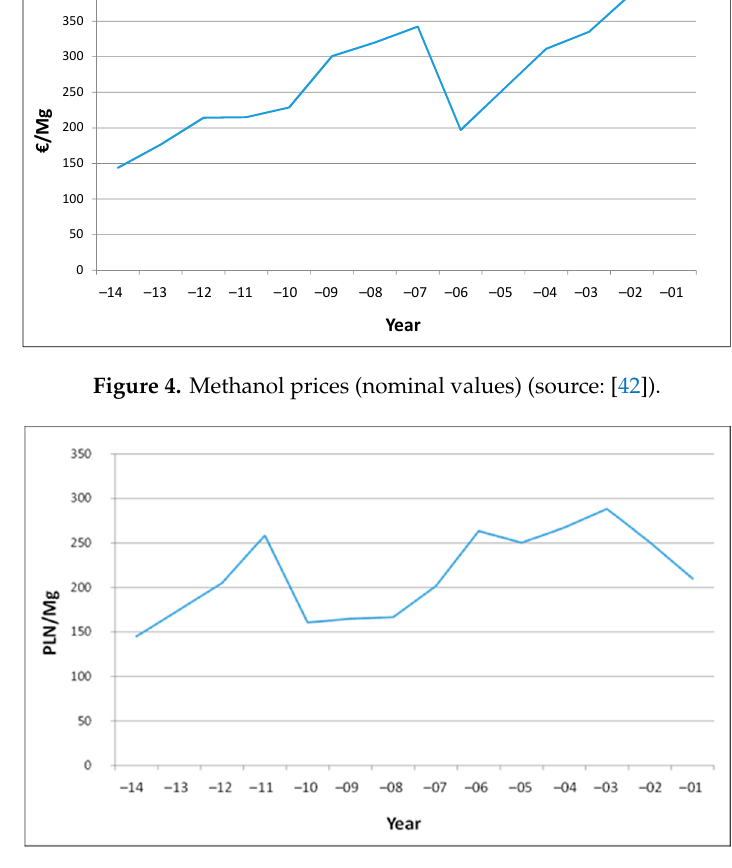
Figure 5. Hard coal prices (source: [43]).